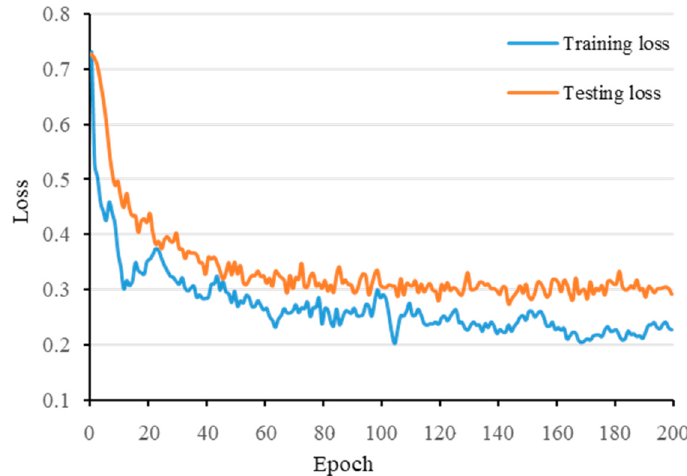
Figure 6. The variation of loss values during the training phase.